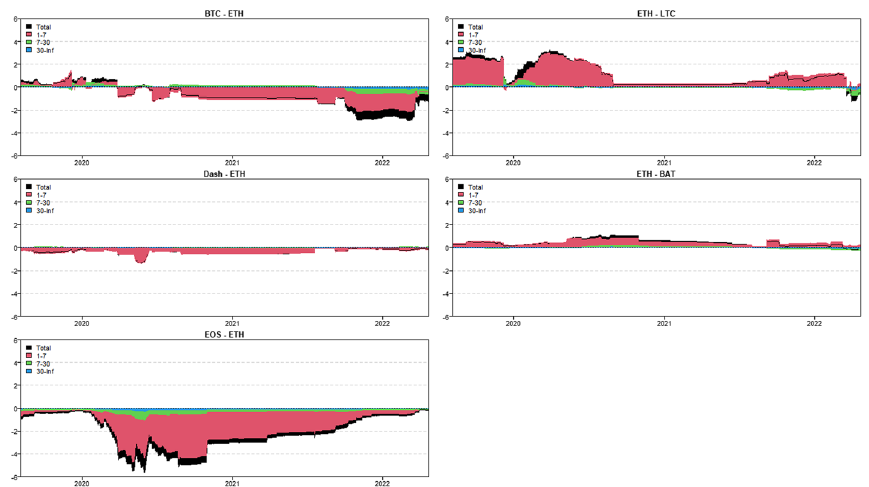
Fig. 29 Dynamic net-pairwise connectedness—realized hyperskewness (RHS)-ETH